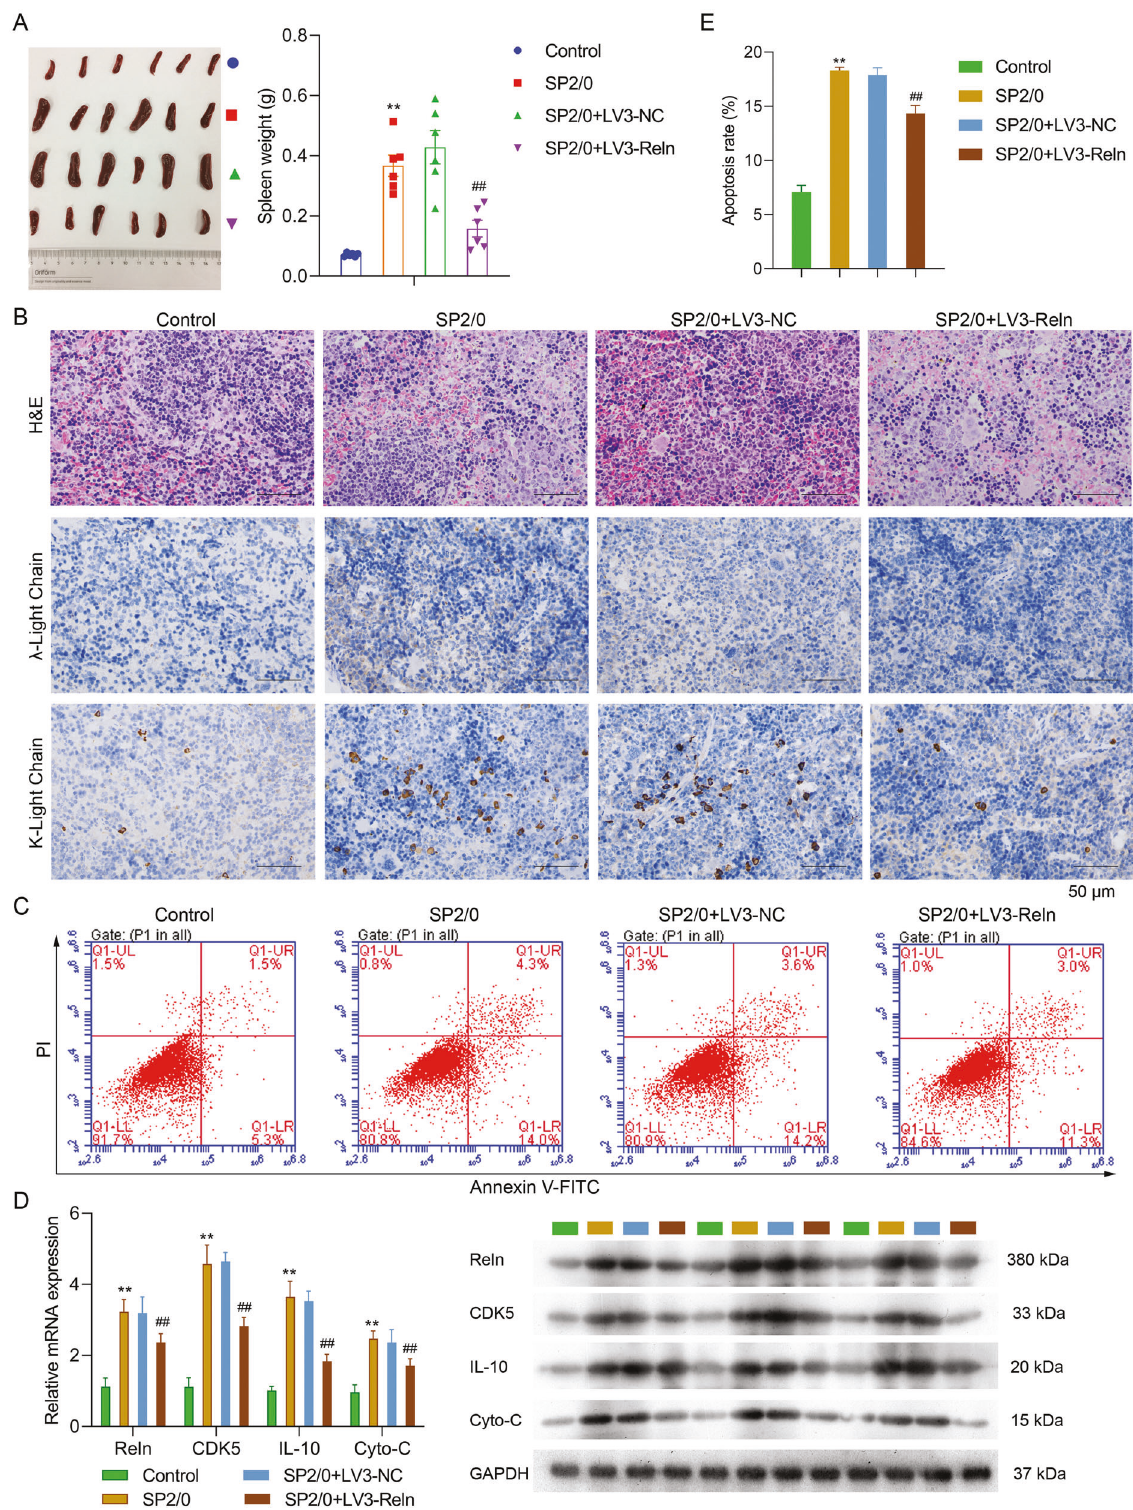
Fig. 4 Reelin knockdown attenuated MM in spleen. A Spleen weight detected in control, SP2/0, LV3-NC and LV3-Reln groups ( n = 6/group). B Representative H&E staining (upper one third panel) and immunoglobulin λ -/ κ -light chain immunohistochemistry (lower two third panel) images in spleen tissues. C , E Apoptosis of immune cells in spleen tissue detected by Annexin V/PI double staining. And apoptosis rate was calculated for each group in ( E ). D mRNA and protein expression of apoptosis-related genes examined by RT-PCR and western blotting respectively and representative bands were shown in the right panel. Reln stands for Reelin. ** p < 0.01 vs. Control group; ## p < 0.01 vs. SP2/0 group.